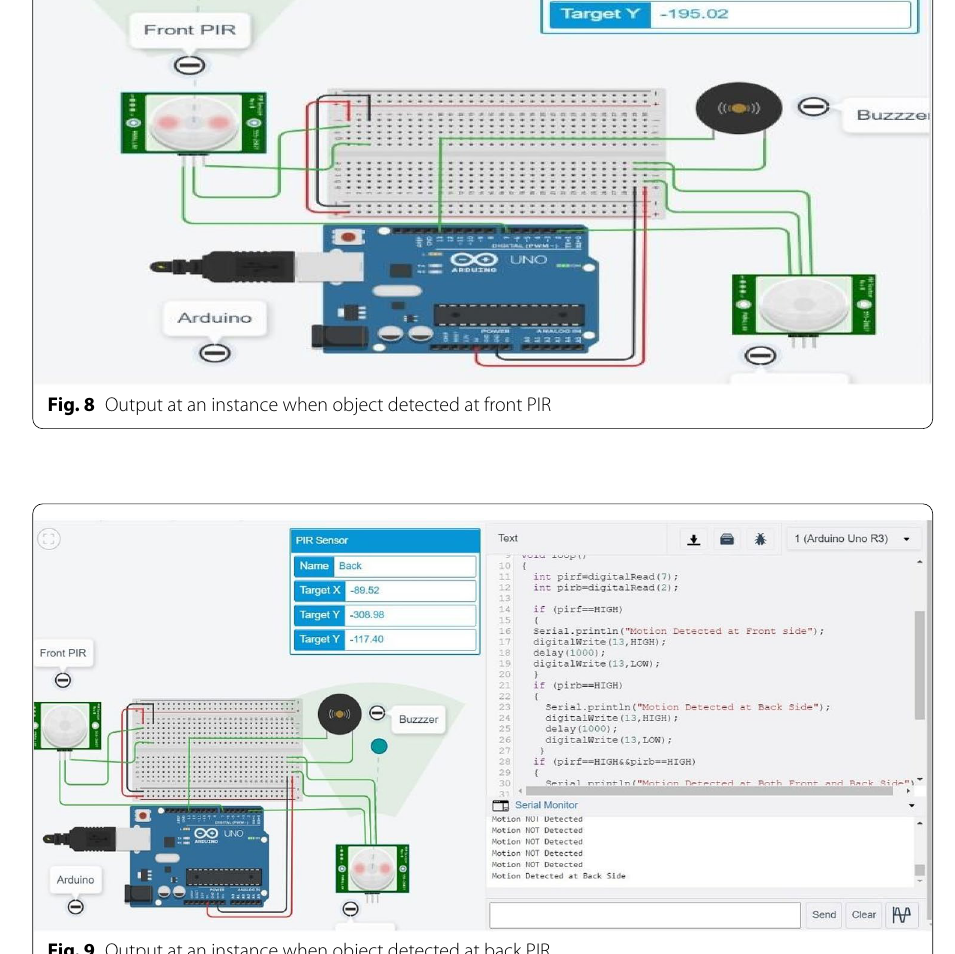
Fig. 9 Output at an instance when object detected at back